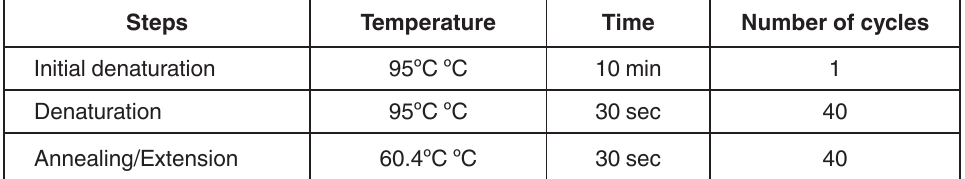
Table 4. Amplification cycle for Campylobacter foetus subsp. foetus used for real-time